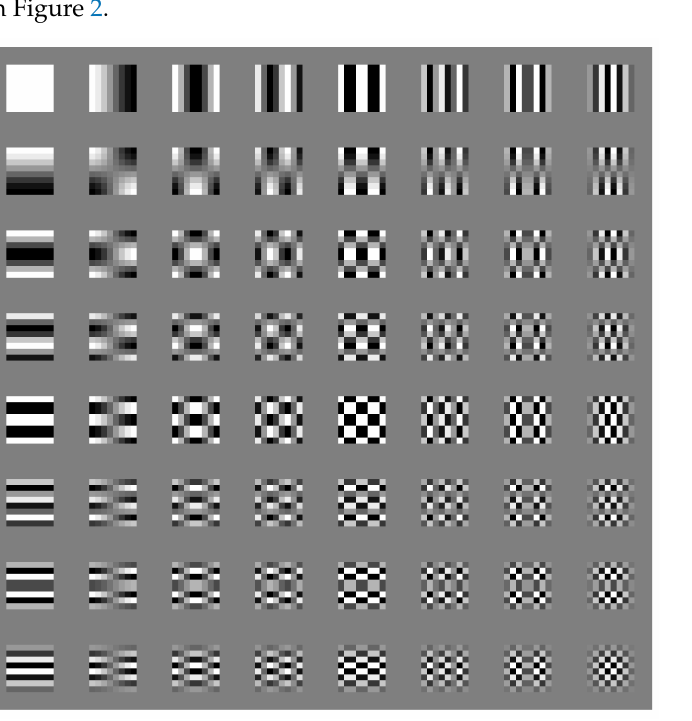
Figure 2. Basis matrices of DCT in JPEG compression. The block on the top left is the DC component. The frequency increases with the increment of both row and column